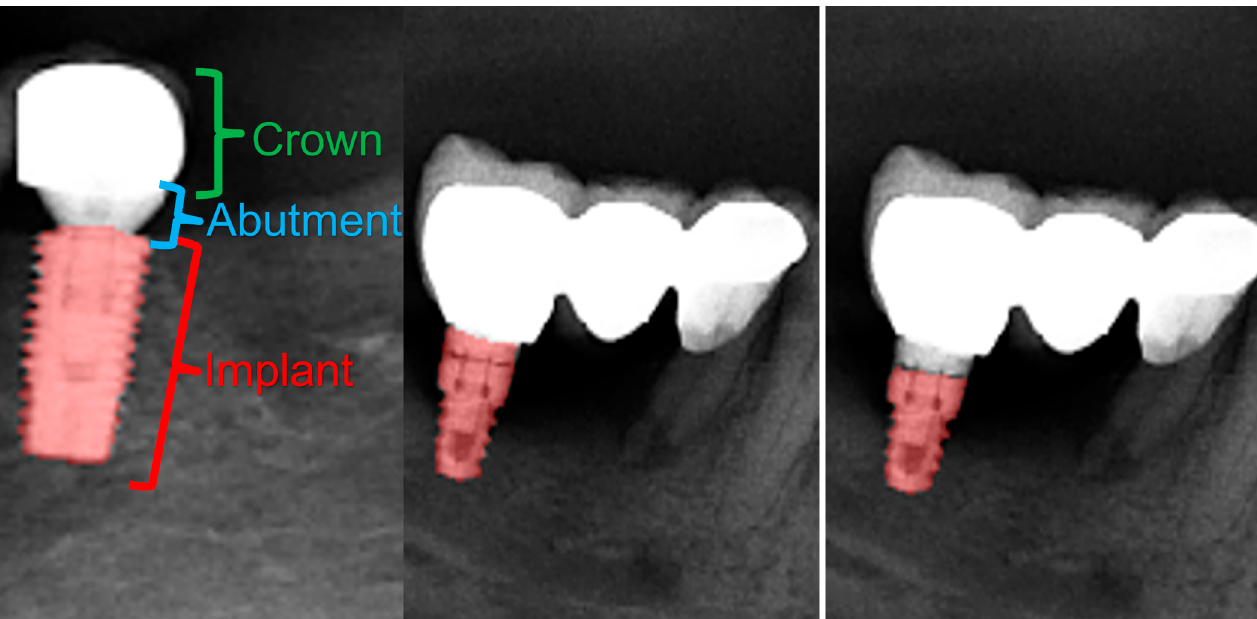
Figure 11. Crown–abutment and implant parts of a dental implant with a crown ( left ). Manual segmentation of the dental implant ( middle ) and automatic segmentation of the dental implant ( right ). Note that the abutment part and the superior portion of the implant were not segmented by our model in this case.